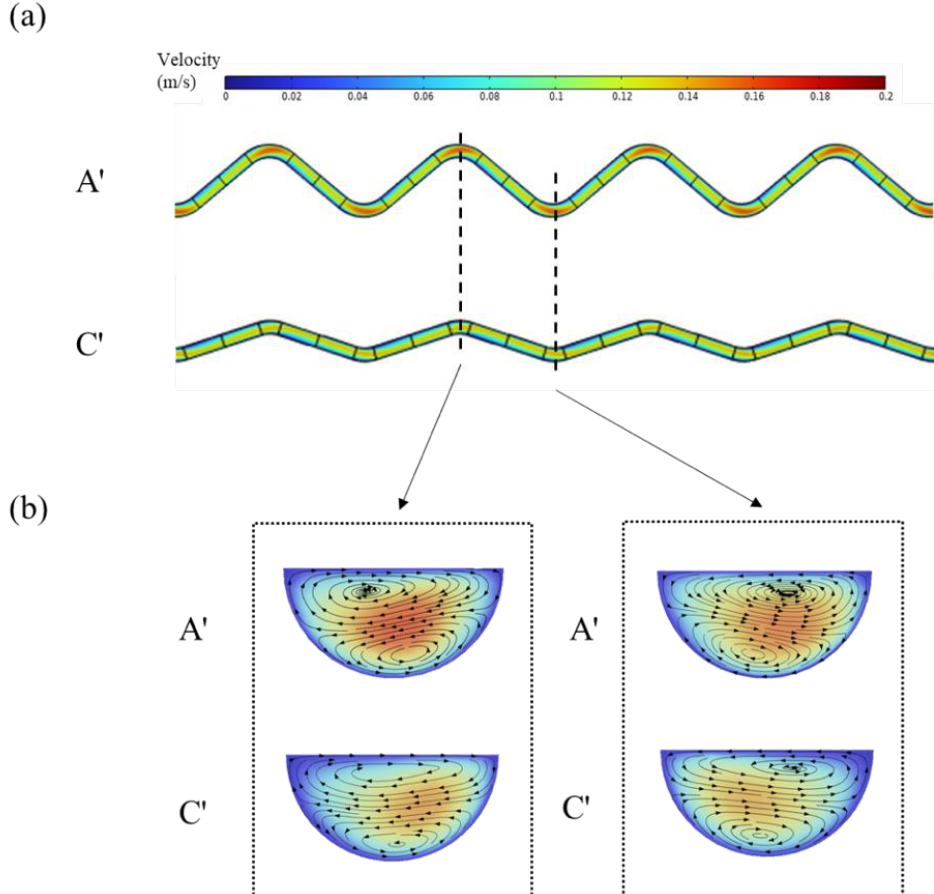
Figure 14. Simulation results at optimal design points A’ and C’ in Figure 12; ( a ) the axial velocity magnitude along the hot water channels, and ( b ) the profiles of axial velocity magnitude and streamline pattern at the turning locations of the flow channels.